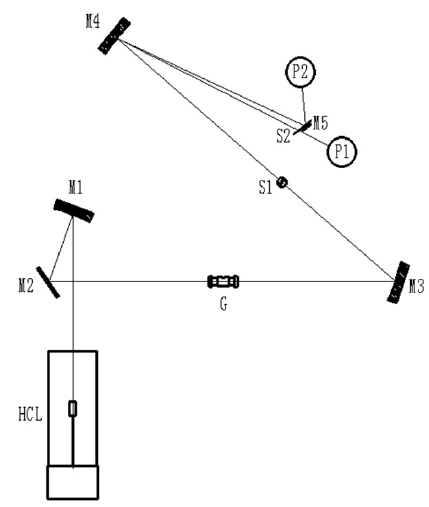
Figure 2. The optical path of atomic absorption spectrometry for Pb–Cd simultaneous determination. HCL: high-performance composite hollow-cathode lamp; M1–M3 and M5: mirrors; M4: concave grating; G: graphite tube; S1–S2: slit components; P1–P2: photomultiplier tubes.